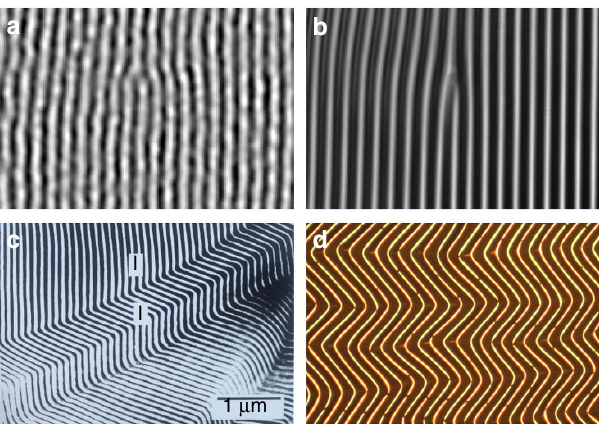
Figure 1 | Smectic patterns in wrinkles. Dislocations ( a , b )